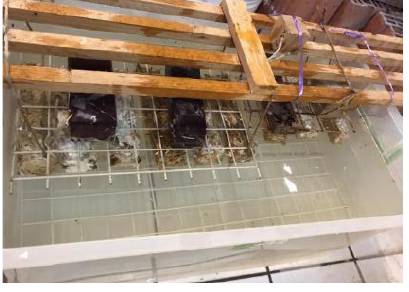
Figure 22 Mechanism Formed for Water Absorption